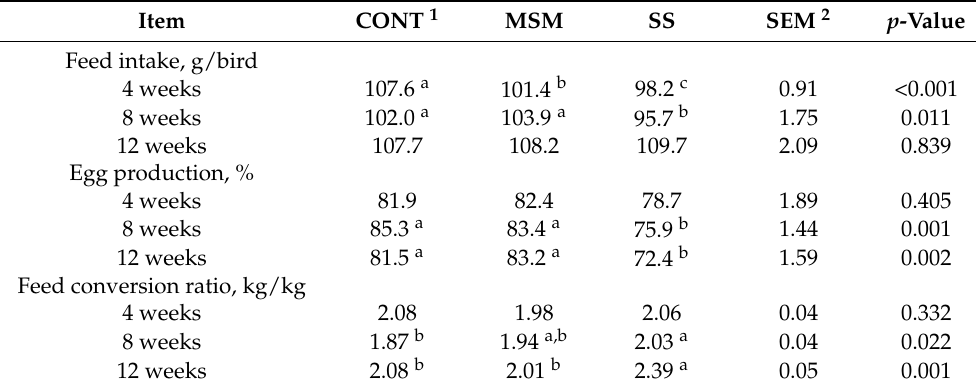
Table 2. Effects of dietary sulfur on production performance in laying hens ( n =